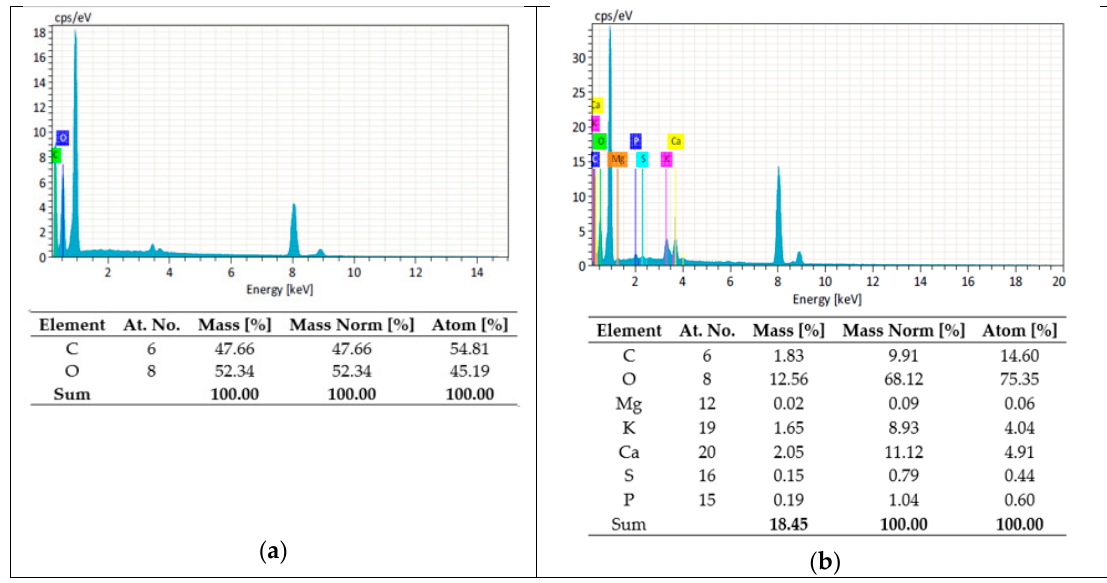
Figure 10. EDS pattern of CF and GOCF fibers: ( a ) CF; ( b ) GOCF.